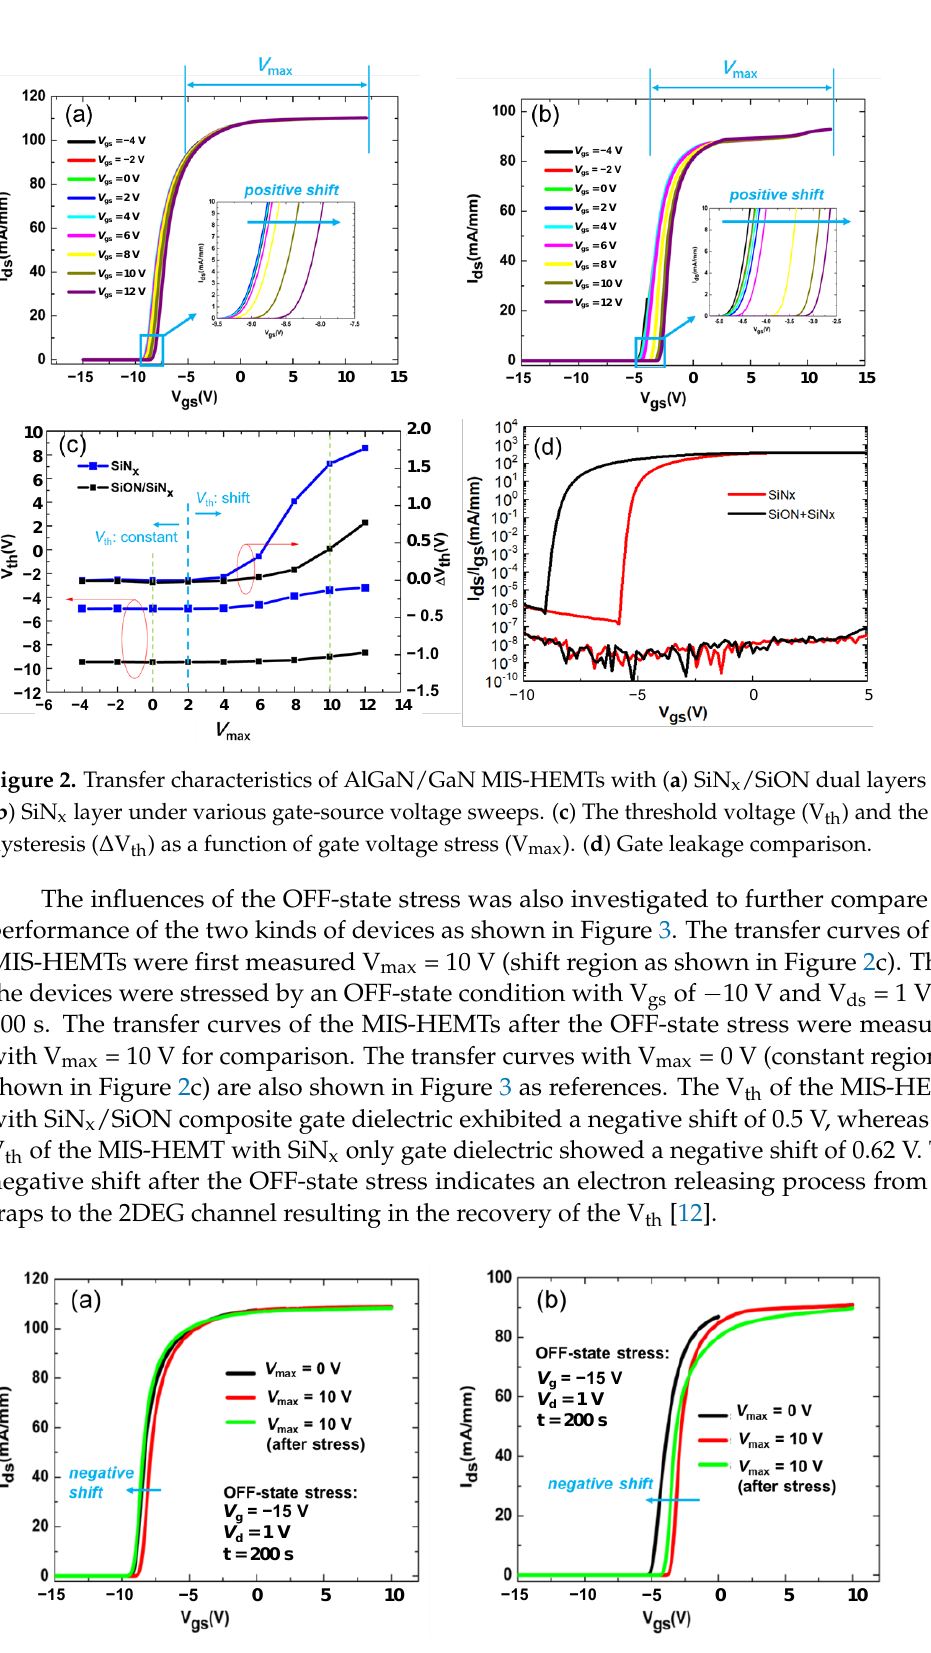
Figure 3. Transfer characteristics of the MIS-HEMTs with ( a ) SiN x /SiON dual layers and ( b ) SiN x layer before (black and red) and after OFF-state stress (green).